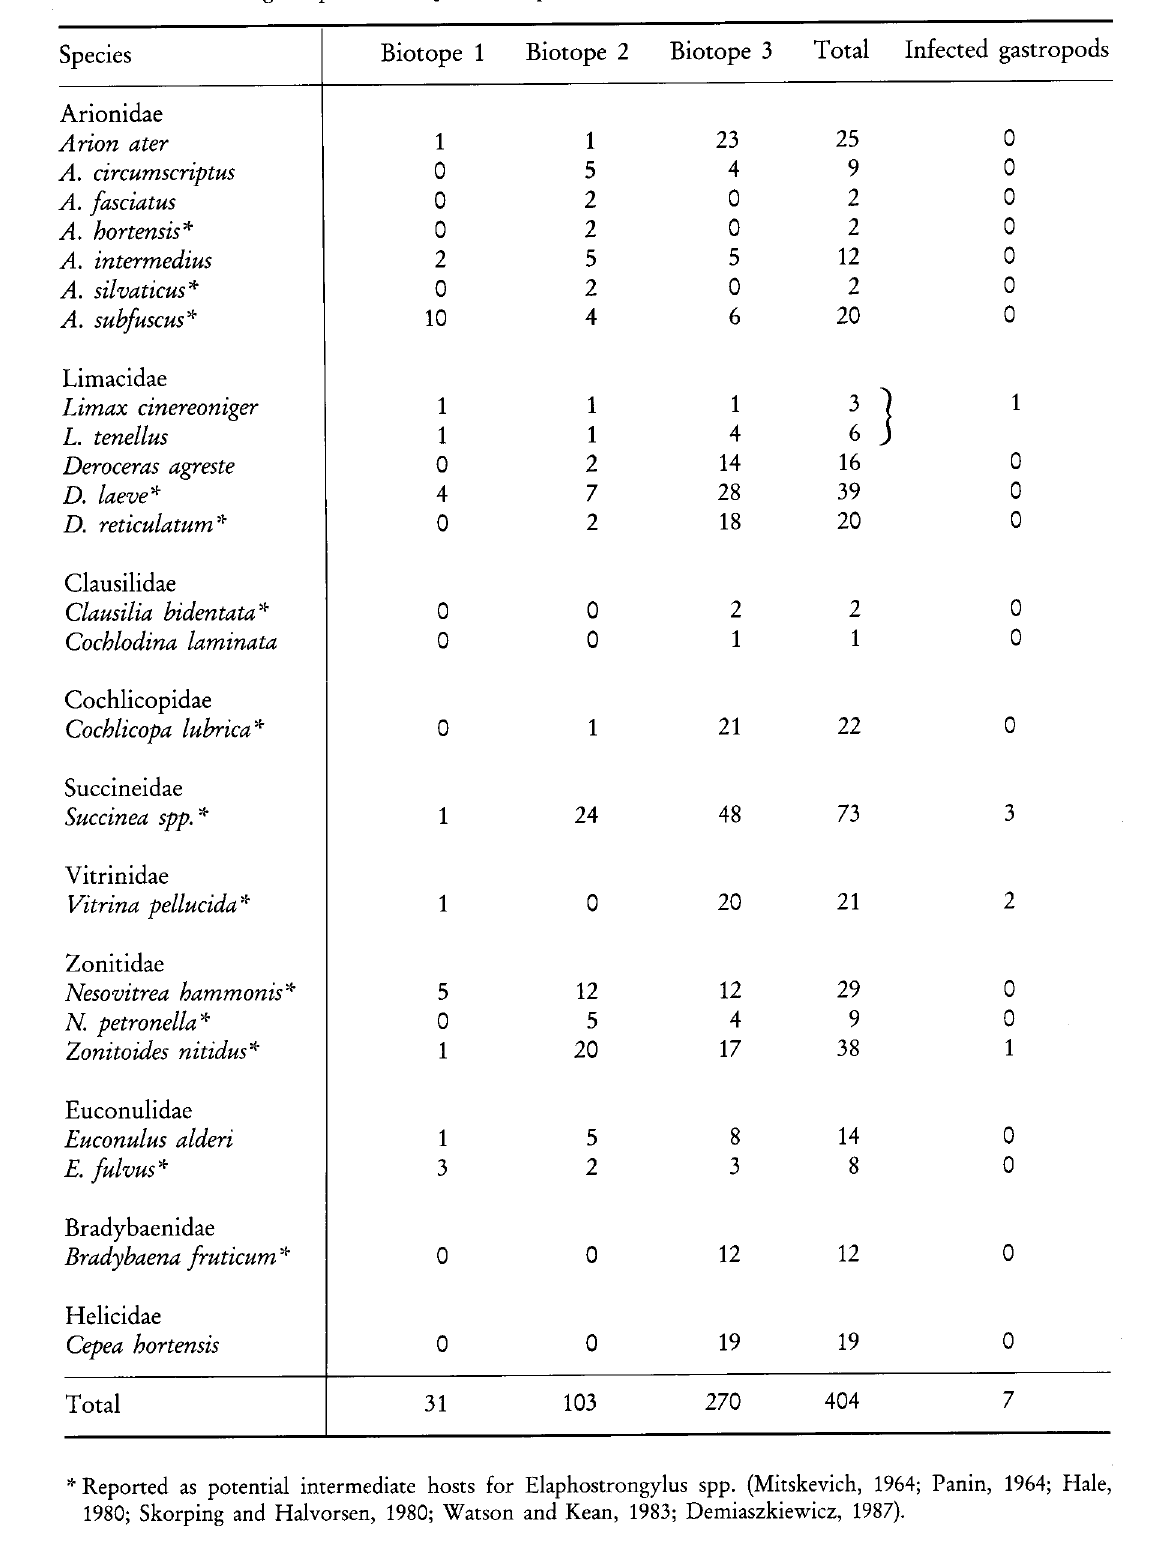
Table 2. Number of gastropods found June to September